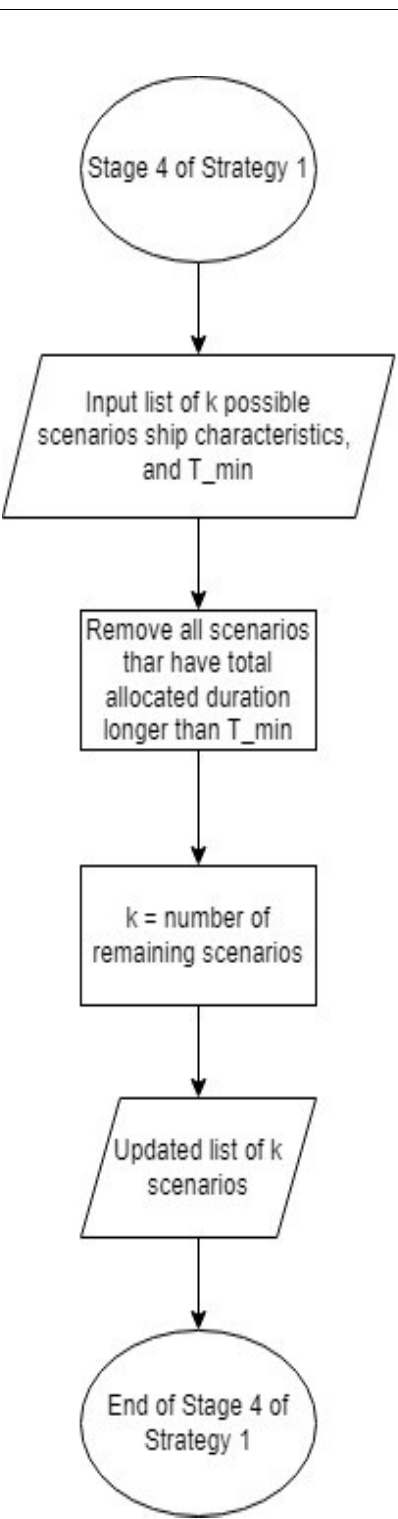
Figure 10. Flowchart for Stage 4 of Strategy 1.